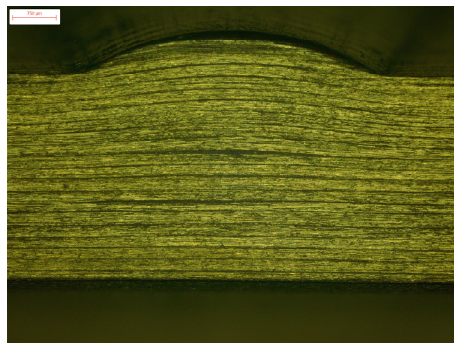
Figure 11. Scanning of the convex fiber waviness.